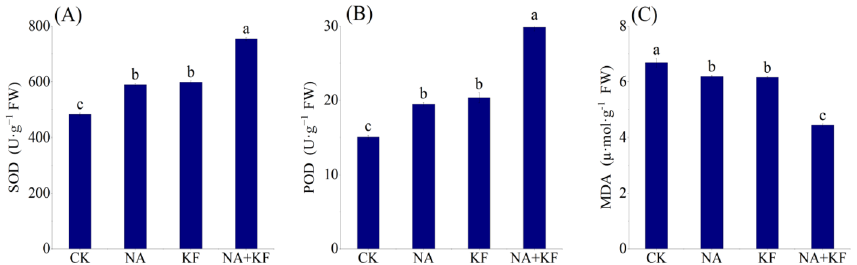
Figure 7. Effects of different treatments on antioxidant enzyme activities and MDA content of tomato seedlings. ( A ) Superoxide dismutase (SOD), ( B ) peroxidase (POD), ( C ) malondialdehyde (MDA),